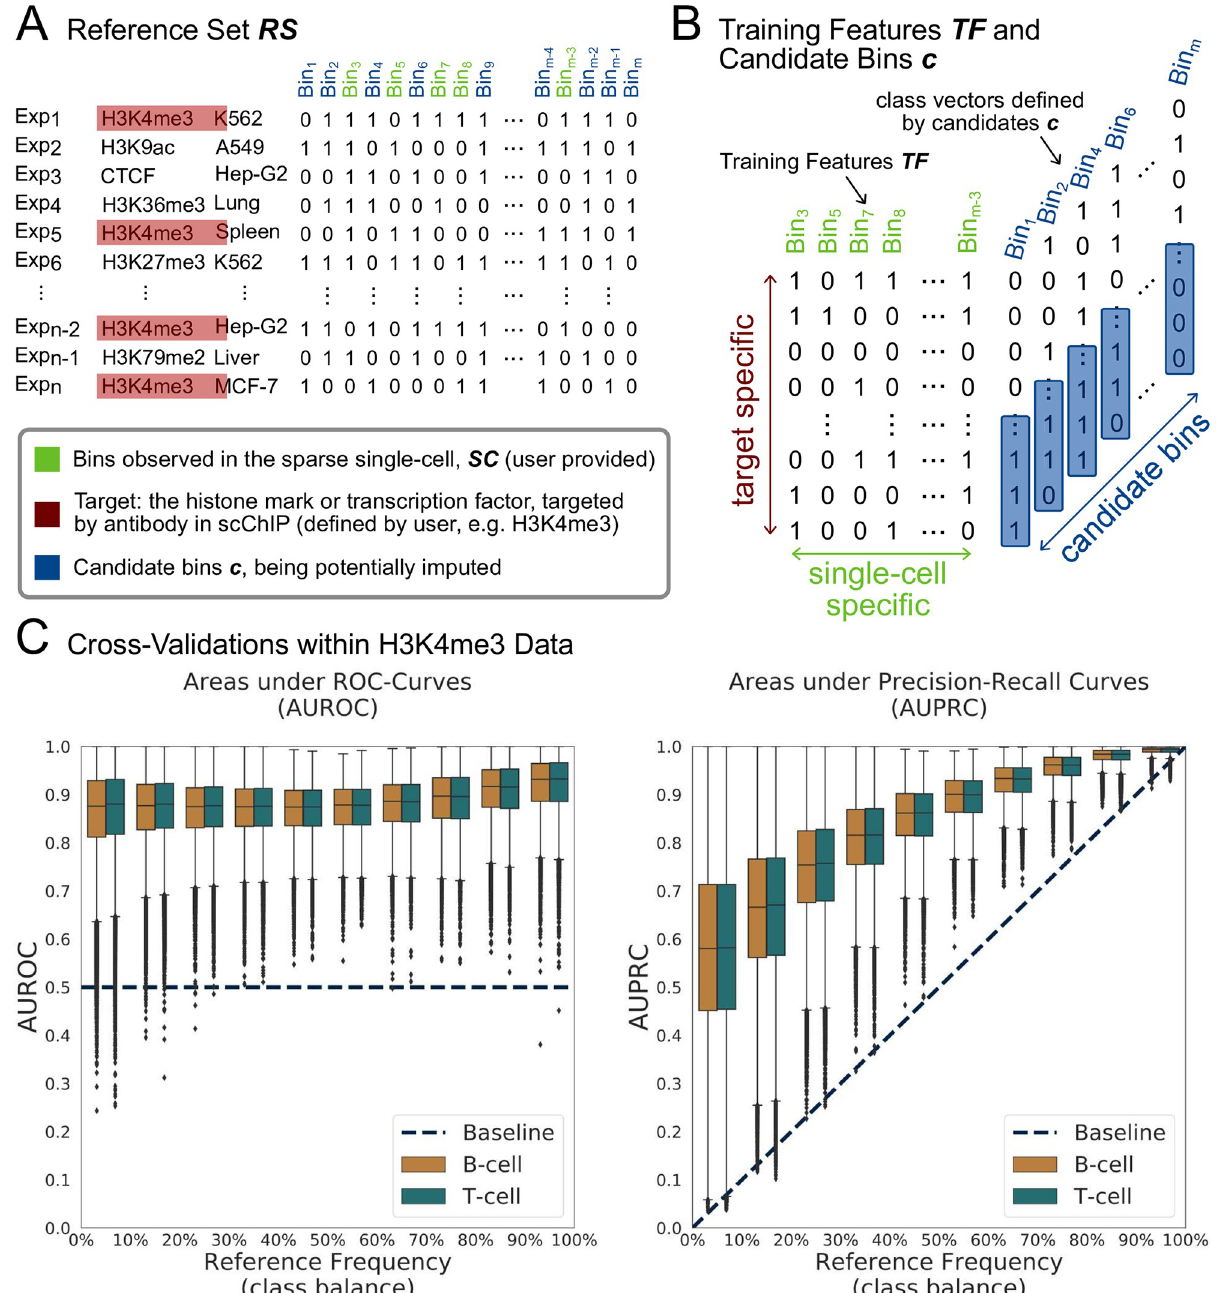
Fig 1. SIMPA’s algorithm and cross validations. A . Identified ChIP-seq regions from bulk experiments were downloaded from ENCODE and mapped to bins defined as non-overlapping and contiguous genomic regions of a defined length (5 kb for H3K4me3 and 50 kb for H3K27me3 in the human dataset) and covering the whole genome (the table). A bin is given a value of 1 for a particular experiment if there is at least one ChIP-seq region in this experiment that overlaps the bin, 0 otherwise. In total 2251 human and 848 mouse ChIP-seq experiments for several targets (histone marks or transcription factors) performed in several biosamples (tissues and cell-lines) were downloaded from ENCODE portal and preprocessed. Depending on the target specified by the user, the target-specific reference set RS is then created and contains all experiments related to this target (rows in red; H3K4me3 is given as example) and all bins observed for at least one of those experiments. B . The single-cell specific training feature matrix TF is created as a subset of RS by selecting only bins observed within the given single cell (green columns). All other bins from RS are the candidate bins ( c ; blue columns) and define the class vectors consisting of the corresponding values in RS . For each candidate bin, a classification model is trained based on the training features and the class vector identifying associated experiments. C . Cross-validated evaluations of SIMPA’s Random Forest performances to predict values of candidate bins defined for real human single-cell data related to H3K4me3. For each candidate bin, a ten-fold cross-